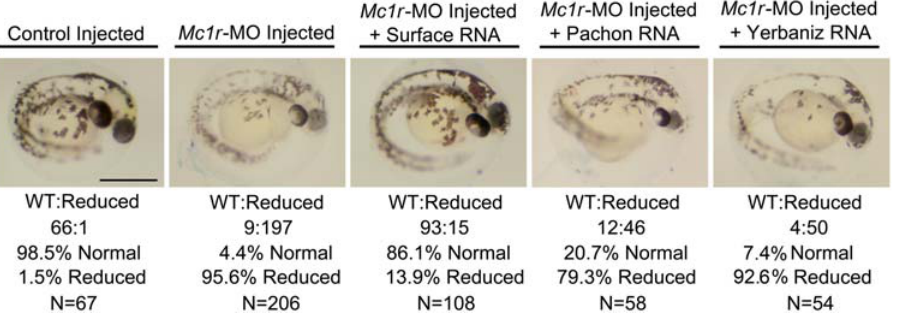
Figure 9. The brown mutation is recapitulated in Mc1r -MO knockdown experiments and is rescued by the Surface form of Mc1r in the zebrafish. Single-celled zebrafish embryos were injected with 0.2 m M of a MO-oligonucleotide directed against the first 25 base pairs of the Danio rerio form of Mc1r (see Methods). Compared with embryos receiving a mock injection of 2 6 1 nl of Danieaux’s solution, embryos receiving MO injections demonstrate significantly reduced pigmentation. This reduced pigmentation phenotype was highly penetrant, occurring in 95.6% of individuals (n=206) receiving the injection. Rescue experiments were performed in which individuals receiving Mc1r -MO injection were co-injected with in vitro transcribed RNA from Surface, Pacho´n, or Yerbaniz constructs. Individuals co-injected with Surface Mc1r RNA were rescued from the reduced pigmentation phenotype (86.1%, n=108). Individuals co-injected with RNA derived from Pacho´n or Yerbaniz allele failed to rescue the diminished pigmentation phenotype (20.7% in 58 individuals; 7.4% in 54 individuals, respectively). Scale bar: 500 m